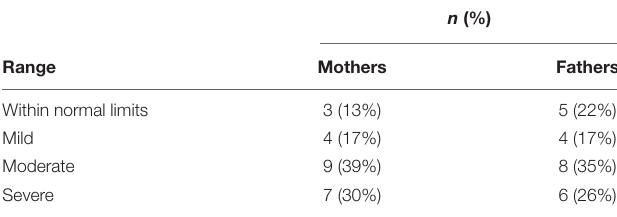
TABLE 9 | Mother-father comparison of SRS-2 total score severity range ( n = 46).